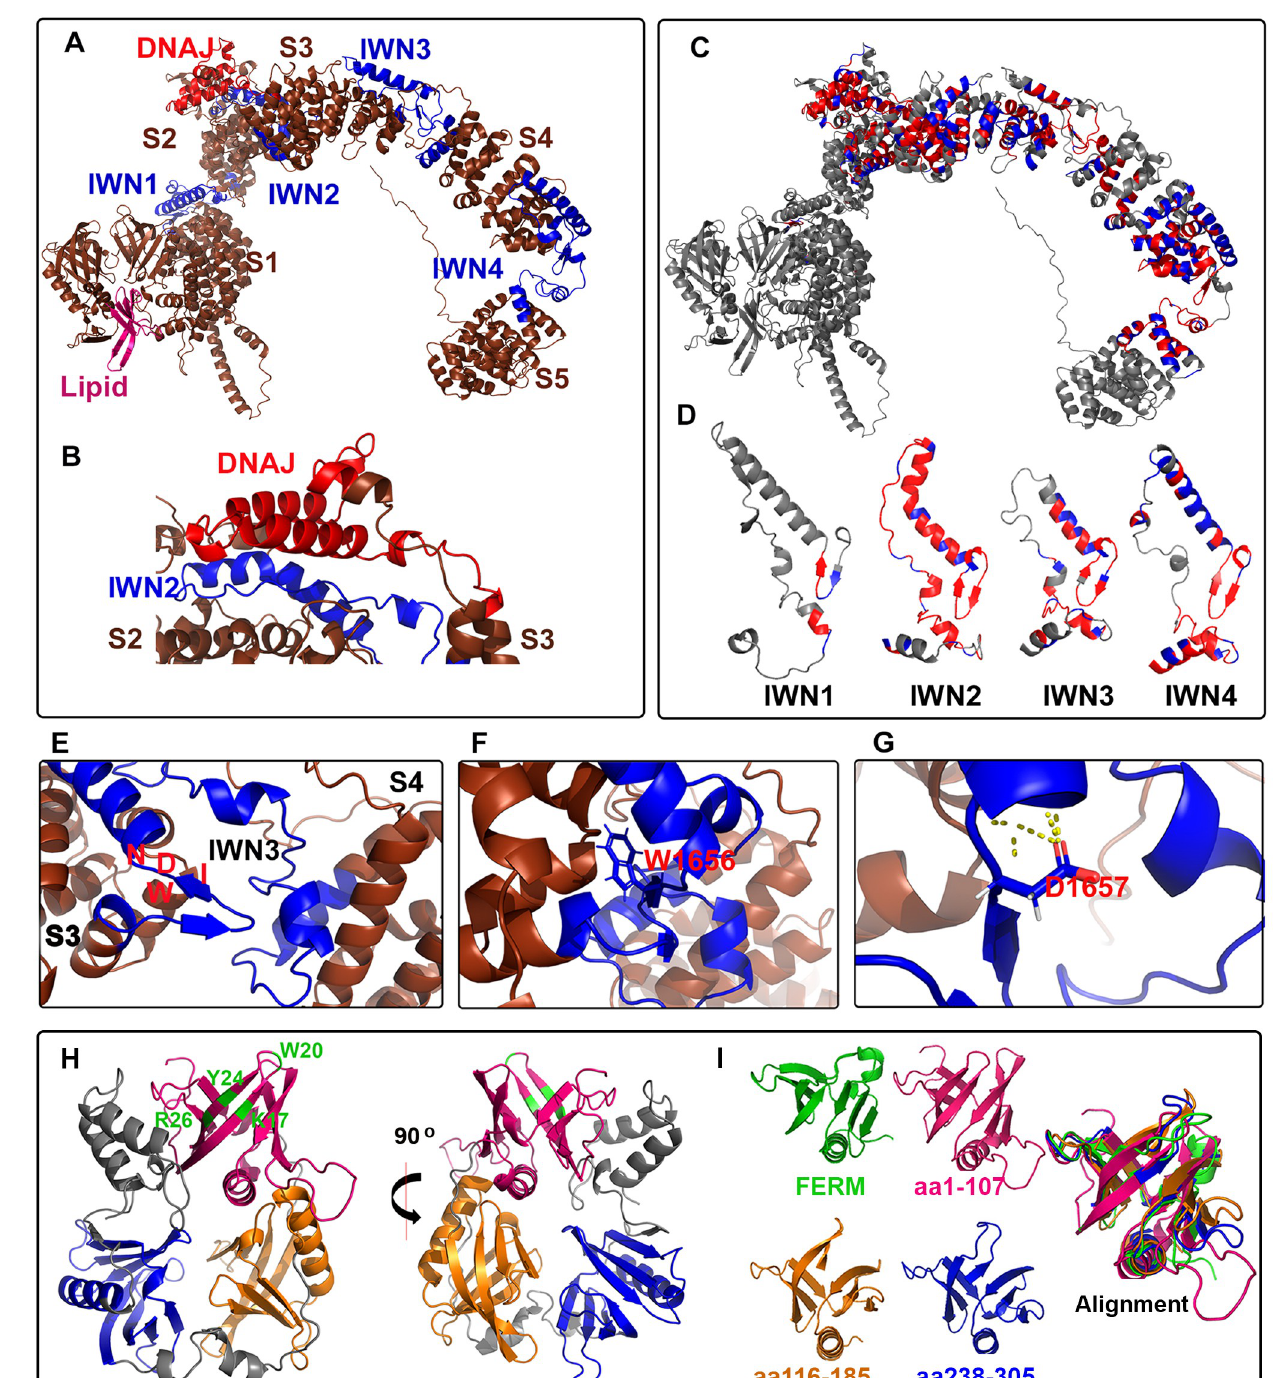
Fig 8. RME-8 AlphaFold structural predictions: conformational control mediated by IWN motifs and lipid binding mediated by three PH-like domains. (A) Ribbon diagram of AlphaFold generated PDB file. The previously defined lipid binding domain is depicted in magenta. IWN domains defined by Zhang et al 2001 are depicted in blue. The DNAJ domain is depicted in red. The five alpha-solenoid regions are labeled S1-S5. (B) A zoomed in view of the juxtaposition of IWN2 and the DNAJ domain, with portions of alpha-solenoid 2 and alpha-solenoid 3 that are separated by the IWN2 elbow-like structure. (C) ribbon diagram demonstrating the conserved residues from Figs 1 and S1. Highly conserved residues are colored in red, moderately conserved residues are colored in blue. (D) Using the same color scheme as panel C, the IWN domains are represented to show their similarity in form as well as conservation across Eukarya. (E) A zoomed in view of the IWN3 linker between alpha-solenoid 3 and alpha solenoid 4. The position of the (I) Isoleucine, (W)Tryptophan, (D) Aspartic acid, and (N) Asparagine of the IWN3 domain are indicated in red. (F) The position of W1656 of the IWN3 domain is predicted to be buried, and